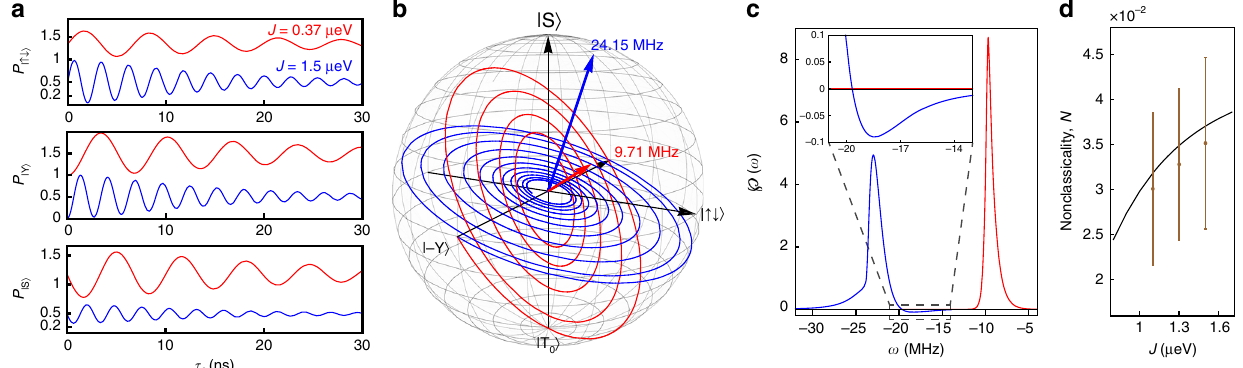
Fig. 3 Nonclassicality of the qubit pair pure dephasing. a A schematic illustration of our extended spin-boson model, describing a pair of non-interacting qubits coupled to a common boson environment. b To simulate the qubit pair pure dephasing, } λ ð Þ is a (quasi-)distribution over R 3 space spanned by λ 3 , λ λ 8 , and 15 . Here we show the six positive root vectors of su ð 4 Þ . Three simple root vectors (blue) de non-simple root vectors (green) can be expressed as a combination of simple ones, e.g., α 9 = α 1 + α 6 + α 13 . c The function } 1 ; 13 x 1 ; x 13 ð Þ distributes over the plane spanned by x 1 and x 13 . For the case of Ohmic spectral density in the zero-temperature limit and ω c = 1, it shows manifest negative regions and therefore indicates the nonclassicality of the qubit pair pure dephasing